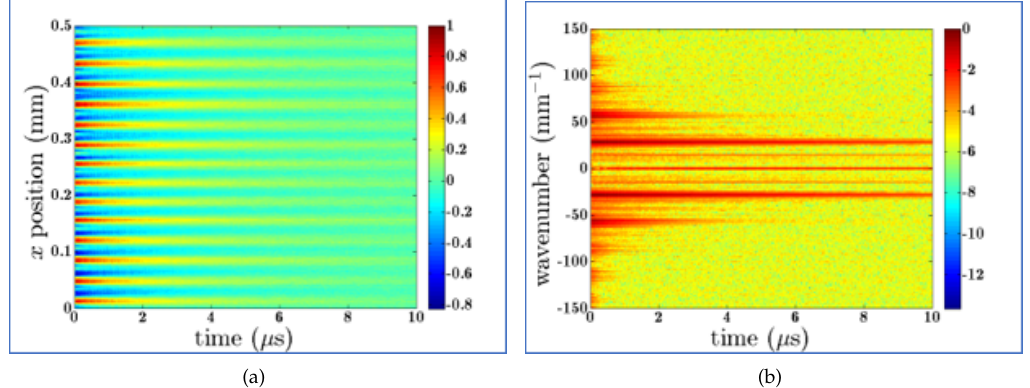
Figure 14. ( a ) Normalized ( x , t ) -signal of the thermal decay at the coating surface of the GESA modified sample excited with a fringe of 35 µ m. The diffraction grating was scanned (d x = 0.5 µ m) in the wave propagation direction. ( b ) Normalized ( k , t ) -signal of the logarithmically scaled thermal decay profile obtained after performing a one-dimensional Fourier transform along the x -direction of the signal in ( a